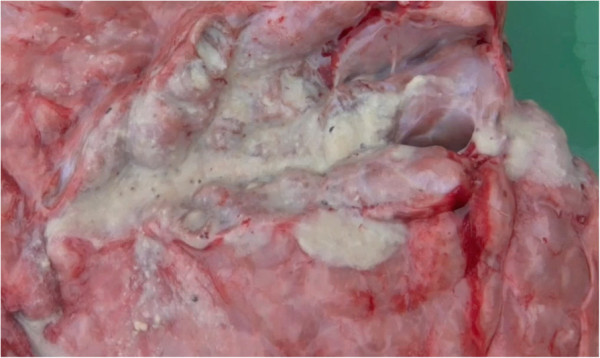
Cut section at necropsy through consolidated lung represented in Figure9.